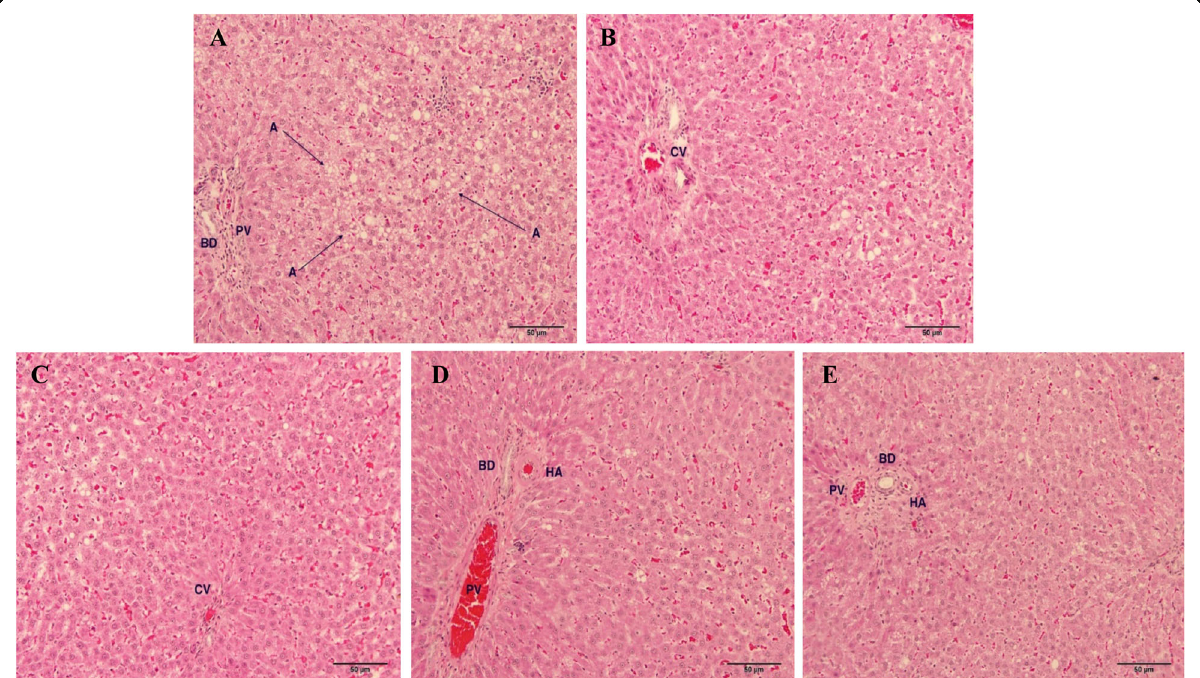
Fig. 4 Light microscopic pathology of liver tissue of rat. H&E stain with magnification of × 20 of objective lens. a Rat in HF group. AA, fat droplets accumulation, b Rat in ML group fed for 12 weeks. c Rat in MM group. d Rat in MH group. e Rat in STAT group. Central vein (CV), portal vein (PV), hepatic artery (HA), bile duct